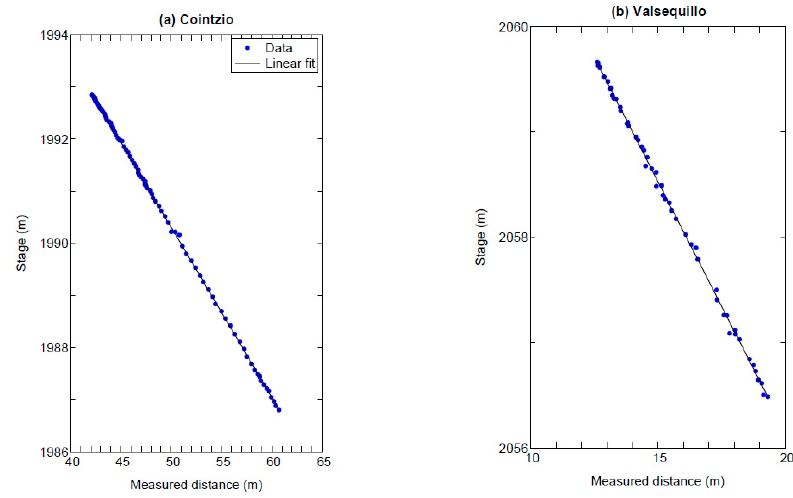
Figure 8. Lidar field-calibration: ( a ) Cointzio (before October 2013) and ( b ) Valsequillo (before 2014).